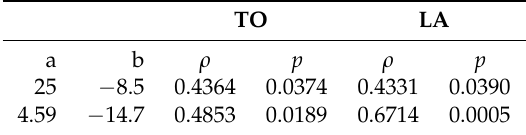
Table 5. Spearman’s ρ ( LF / HF ∗ , OW ) and significance